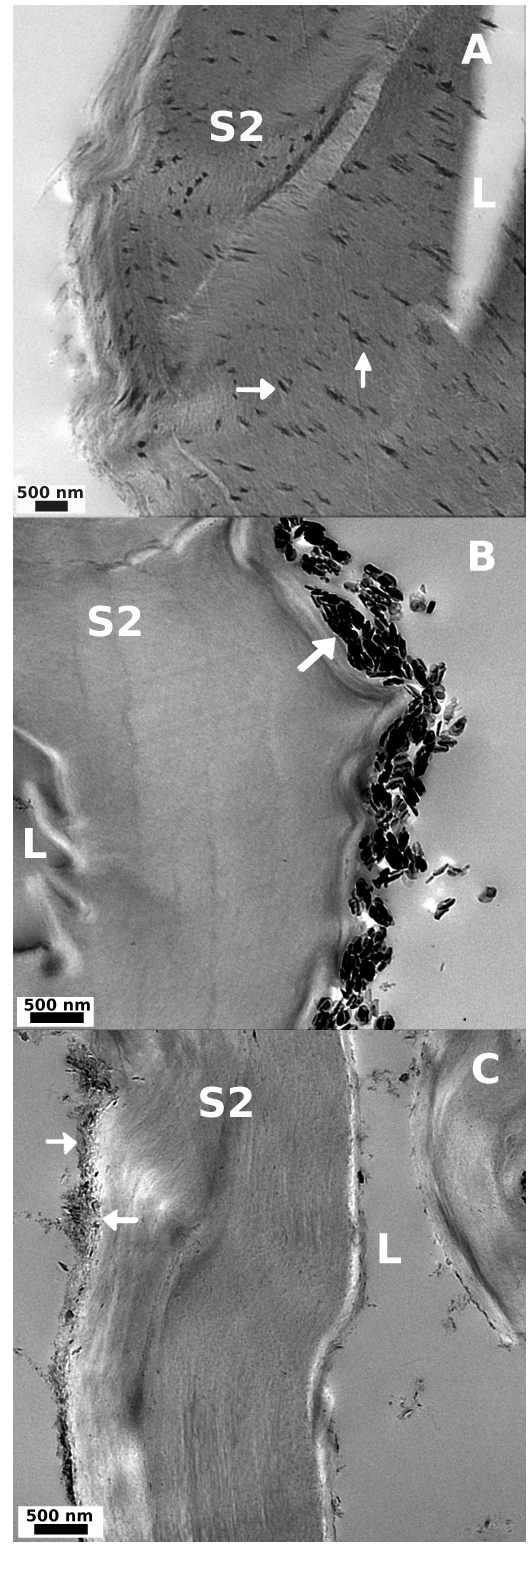
Figure 6. TEM images from transverse cut ( A ) Uhyd and ( B ) hss ; and ( C ) longitudinal cut lss treated fibers. The particle size follows the order LDH-U > LDH-C > LDH-OH. Fiber lumen (L) and cell wall (S2) are visible in all samples. LDH is marked with